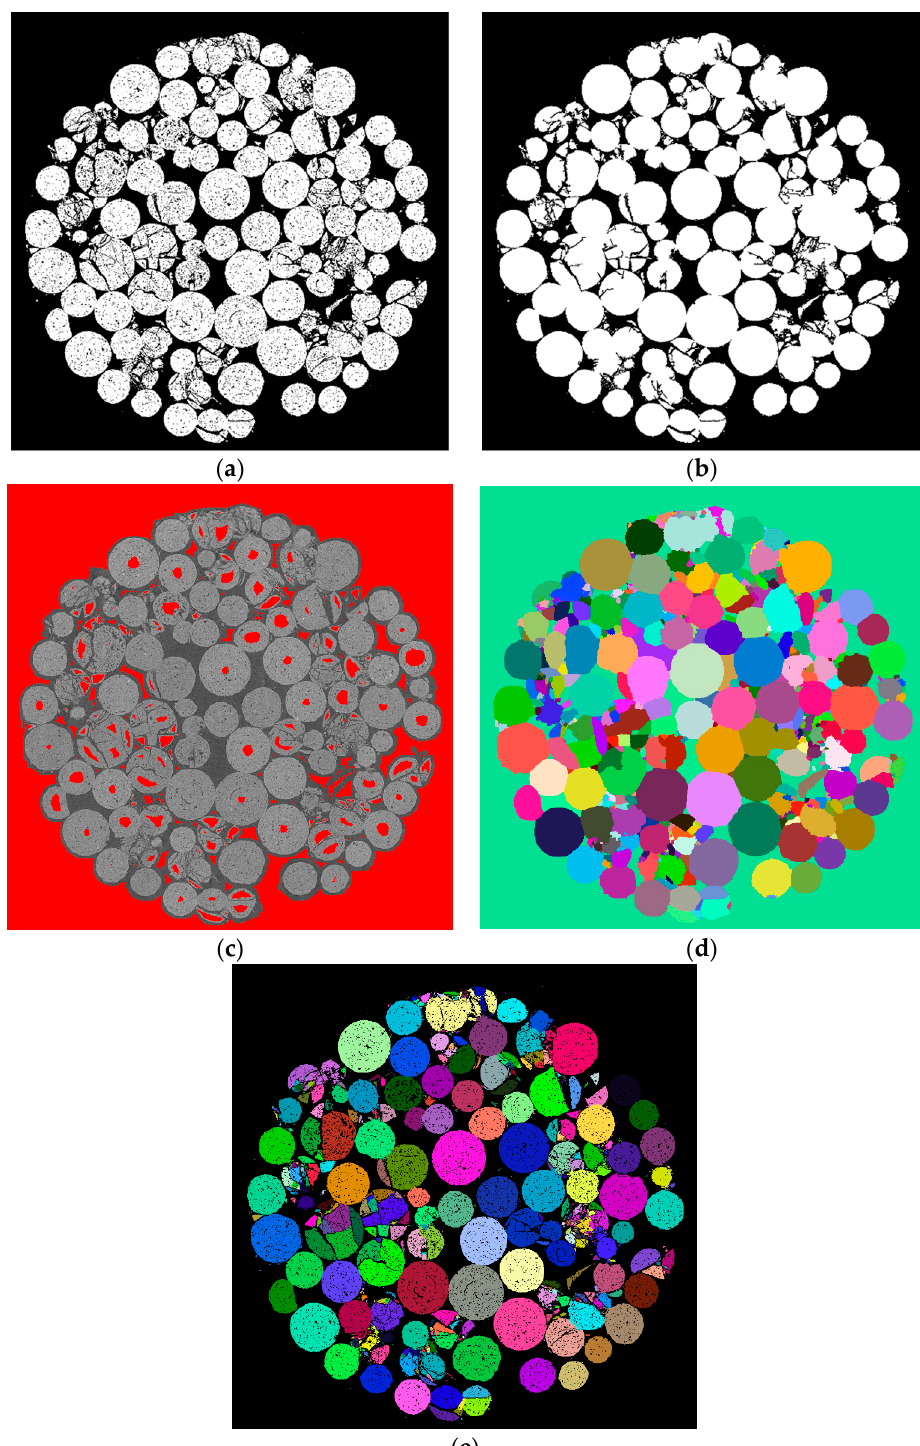
Figure 6. Examples of segmentation stages outcomes for B image: ( a ) Thresholded image; ( b ) Result of holes filling in 2D; ( c ) Markers; ( d ) Labels after watershed; ( e ) Labeled image.